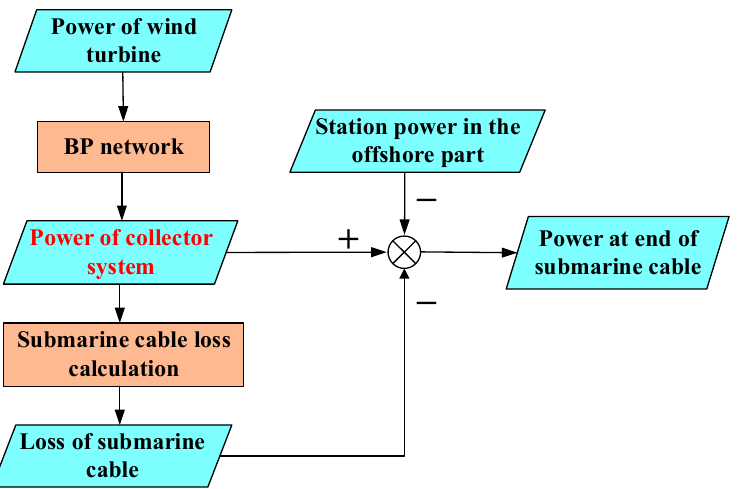
Figure 5. Mapping process from wind turbine power to the power at end of submarine cable.